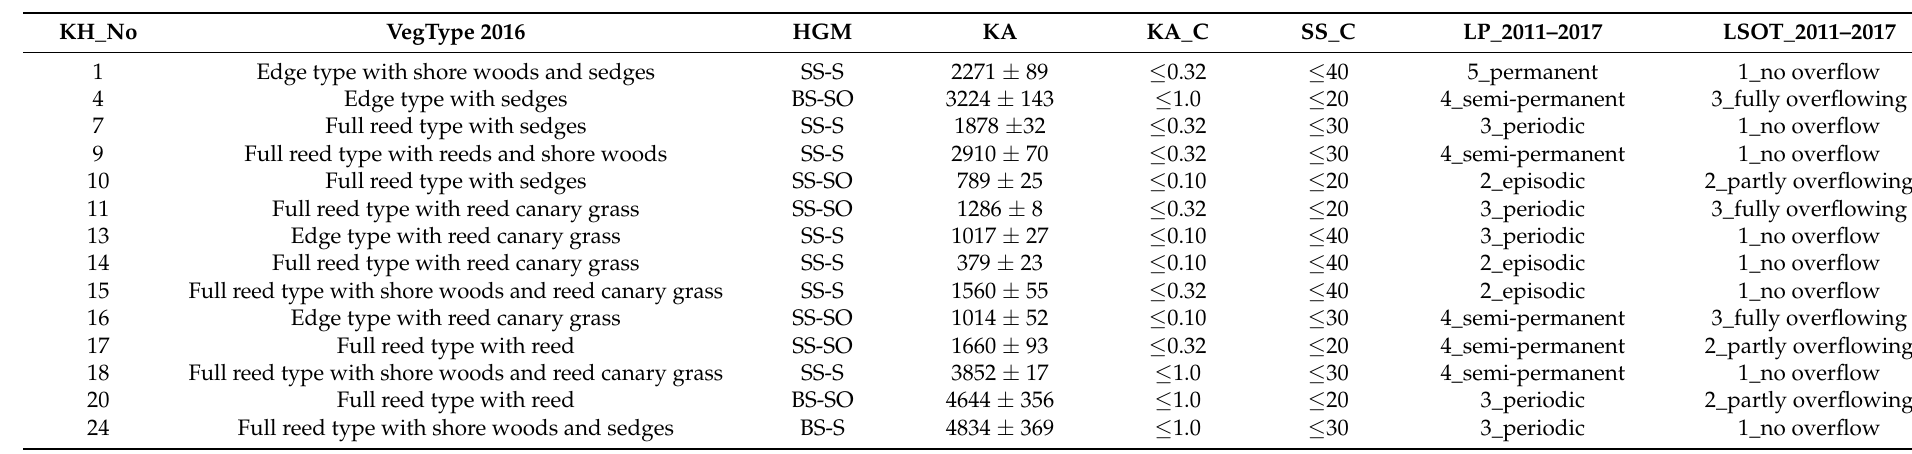
Table 1. Hydrogeomorphological characteristics (Kalettka and Rudat [37]) and dominant vegetation types for the year 2016 (after Kalettka and Rudat, unpublished) of the selected 14 kettle holes. KH_No = kettle hole number according to numbering within the SWBTrans project (ZALF), Vegtype2016 = dominant vegetation type in 2016. HGM = hydrogeomorphological type: BS-S = big and shallow storage type, BS-SO = big and shallow shore overflow type, SS-S = small and shallow storage type, SS-SO= small and shallow shore overflow type. KA = mean area of the kettle hole between 2016 and 2020, measured up to the tilled area of the adjacent field in square meter. KA_C = size class of the mean area of the kettle hole in hectare: 1 = very small ( ≤ 0.03 ha), 2 = small ( ≤ 0.10 ha), 3 = medium ( ≤ 0.32 ha), 4 = large ( ≤ 1.0 ha). SS_C = class of shore slope in percent: 1 = flat ( ≤ 10%), 2 = oblique ( ≤ 20%), 3 = very oblique ( ≤